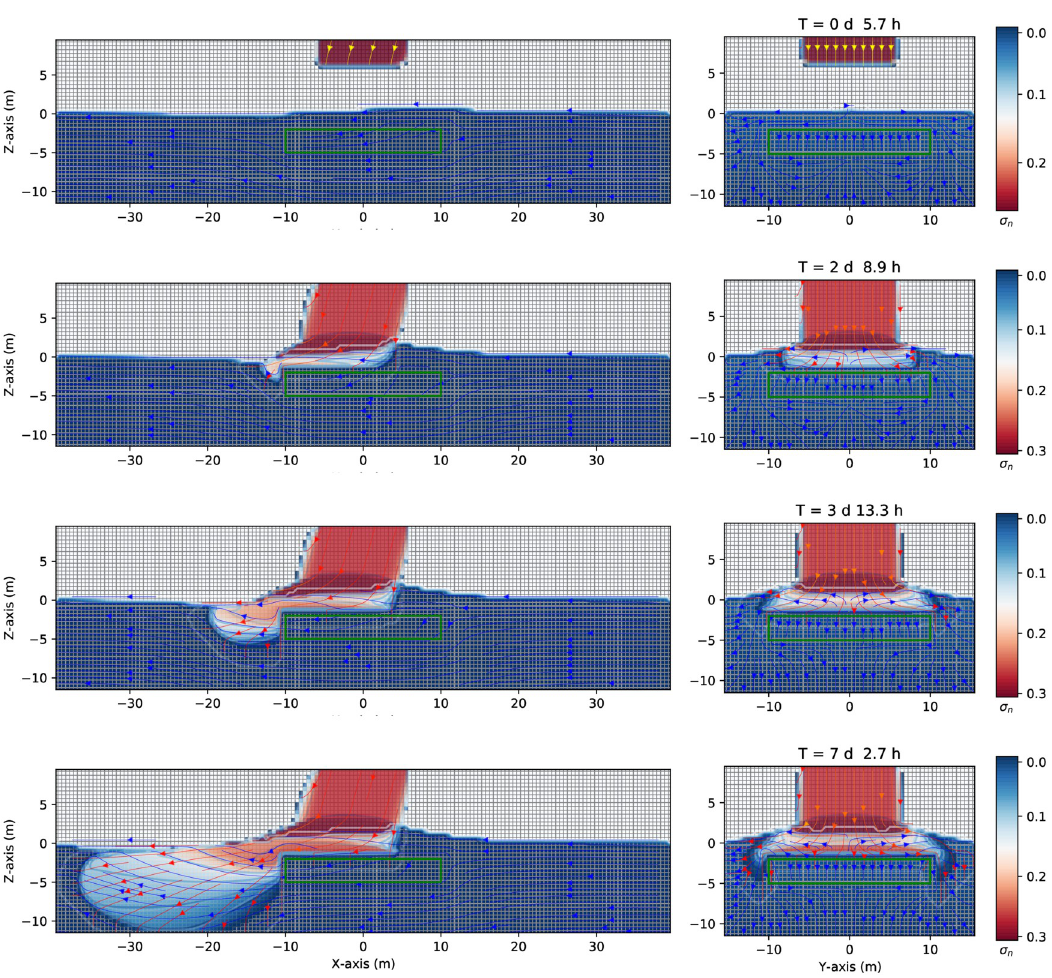
Fig 17. Saturation contours of DNAPL (with an impermeable in the groundwater) at different times. Three-dimensional numerical simulation results of the saturation contours ( σ source of DNAPL + air) using a spatial grid resolution of 0.50 m and a grid dimension of 80 m × 32 m × 22 m , at different times. The DNAPL encounters an impermeable obstacle (depicted in green), situated at z = [ − 5.0, − 2.0] m , x = [ − 10.0, +10.0] m , y = [ − 10.0, +10.0] m